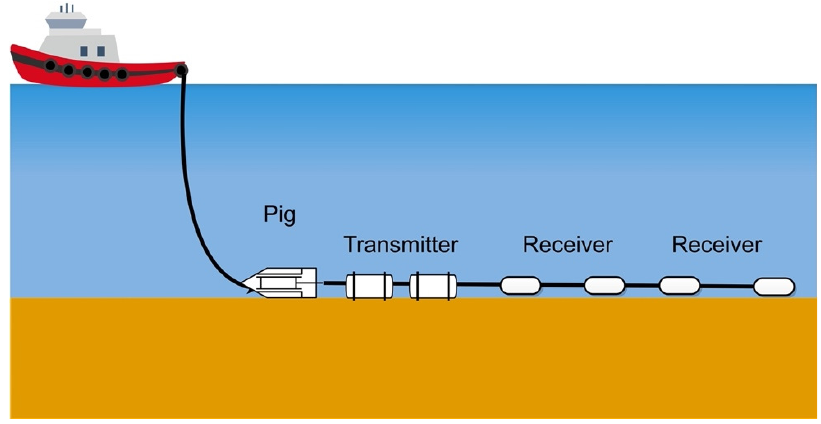
Figure 5. The single-line